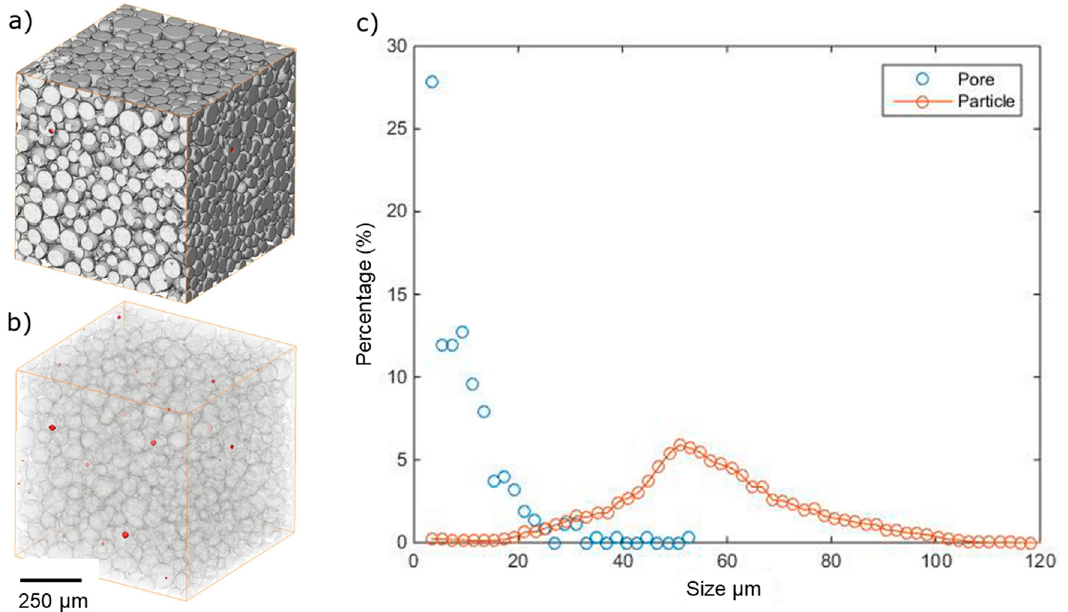
Figure 3. CT-scan of a volume of gas atomised pre-alloyed powder: ( a ) Reconstructed volume showing the powder particles; ( b ) internal particle pores highlighted over the powder image; ( c ) particle and pore size distribution found in gas atomised particles.